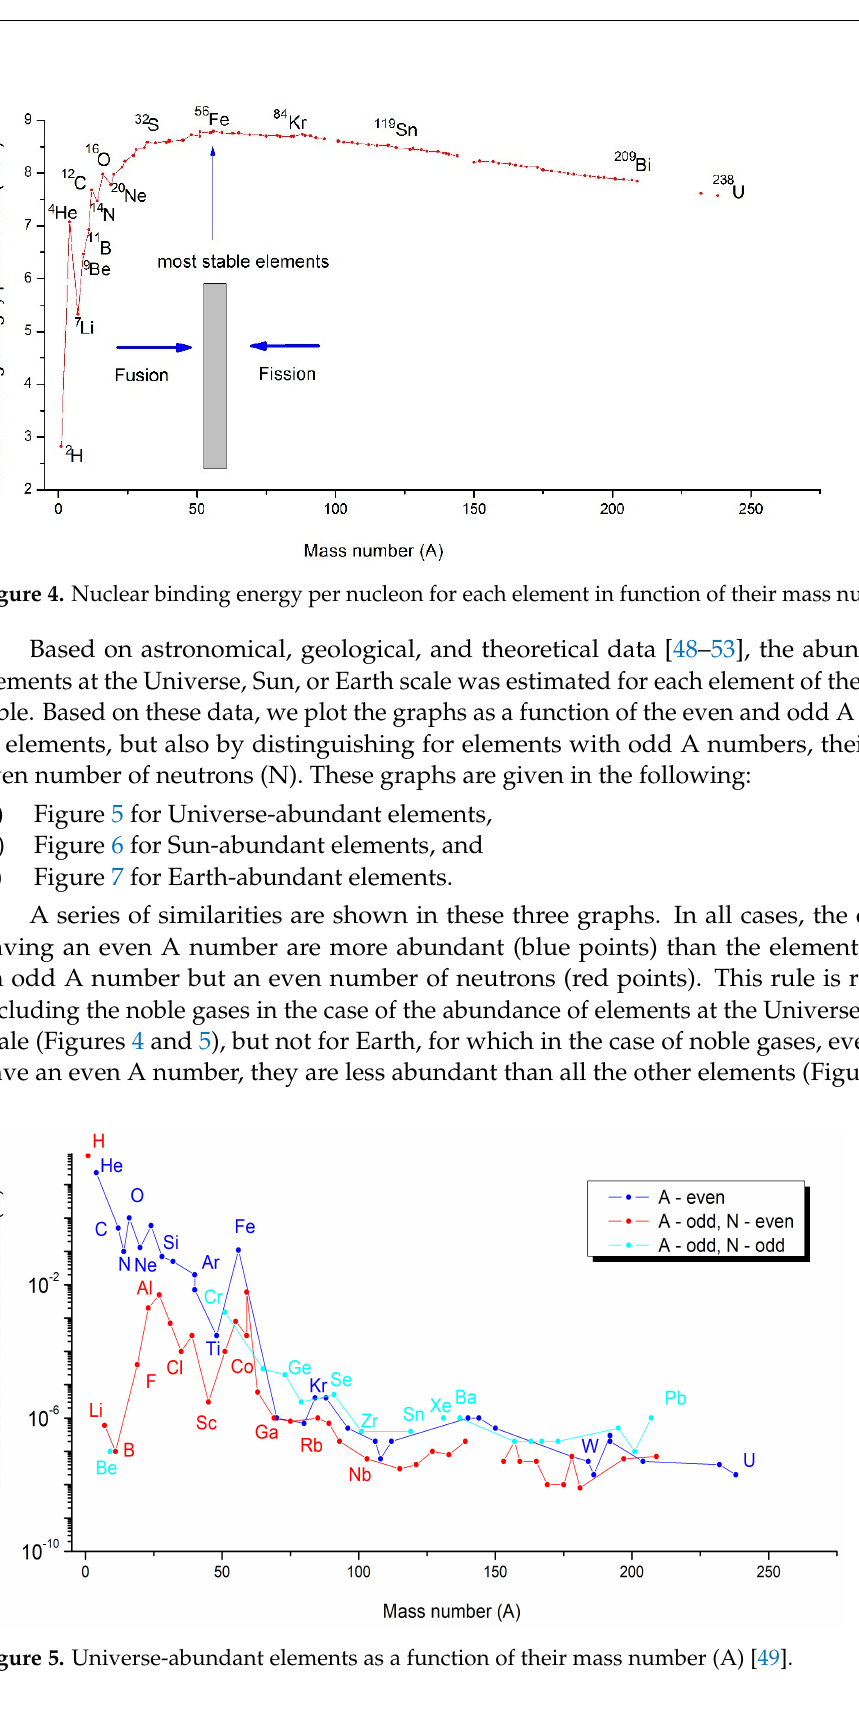
Figure 5. Universe-abundant elements as a function of their mass number (A) [49].